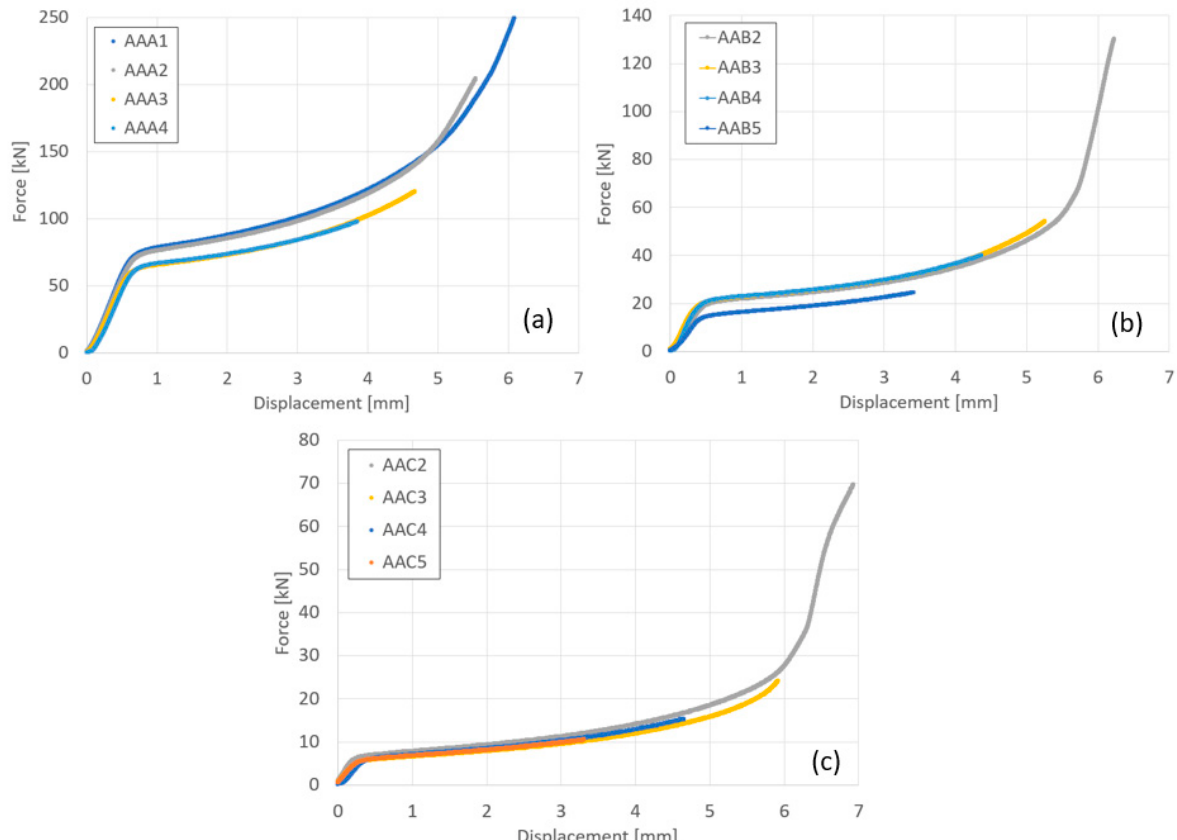
Figure 4. Force–displacement curves of the couples of Al6061 compressed at the following different temperatures: 300 °C ( a ), 400 °C ( b ), and 500 °C ( c ).